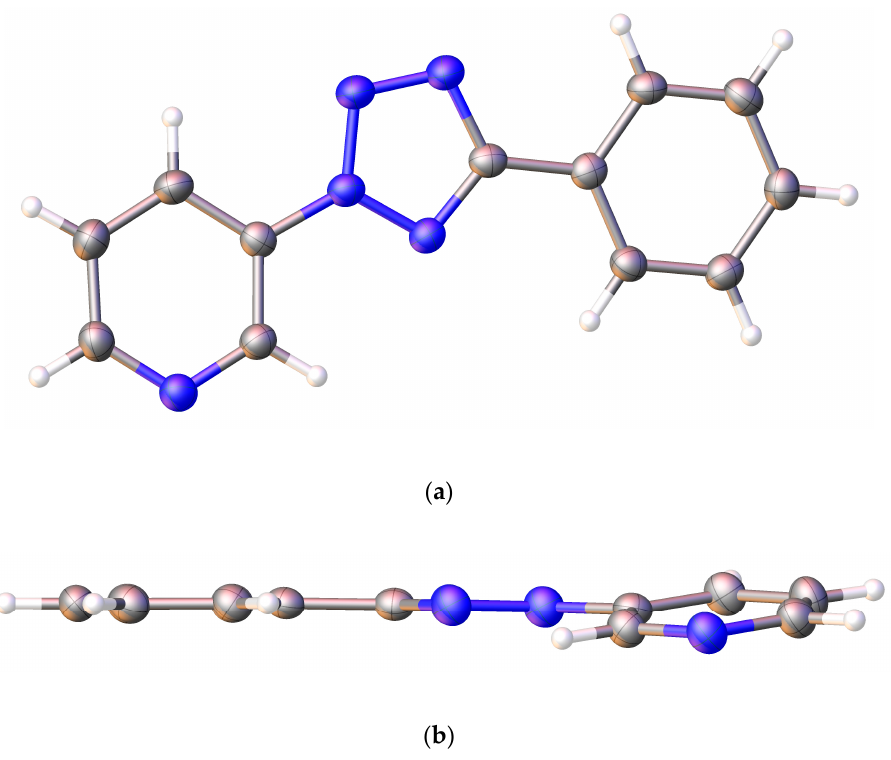
Figure 3. Structure of compound 1 obtained from X-ray diffraction analysis: ( a ) front view; ( b ) side view. The crystal data for compound 1 are presented in Table 1. Table 1. Crystal data and structure refinement parameters for 3-(5-phenyl-2 H -tetrazol-2-yl)pyridine 1